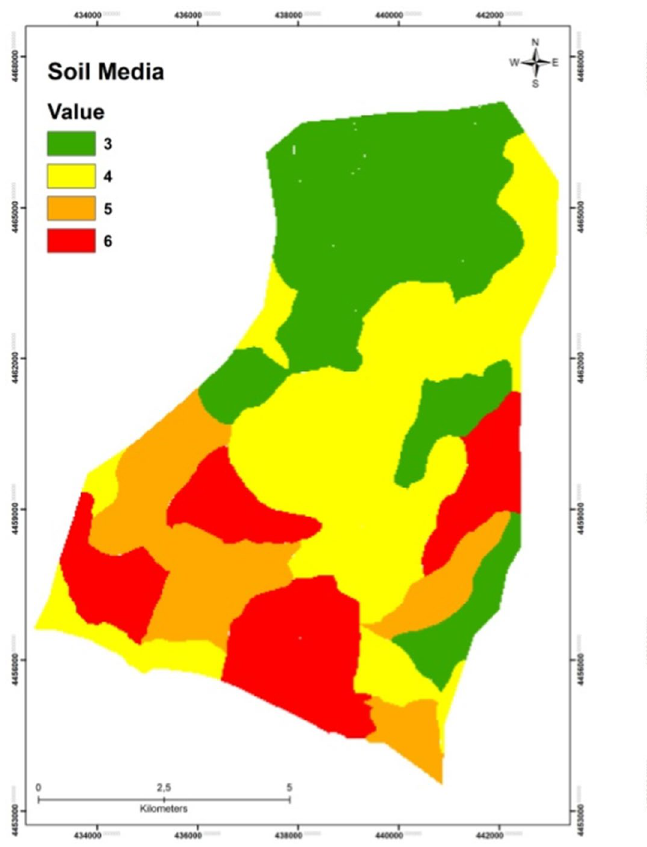
Fig. 4 Topography of the study